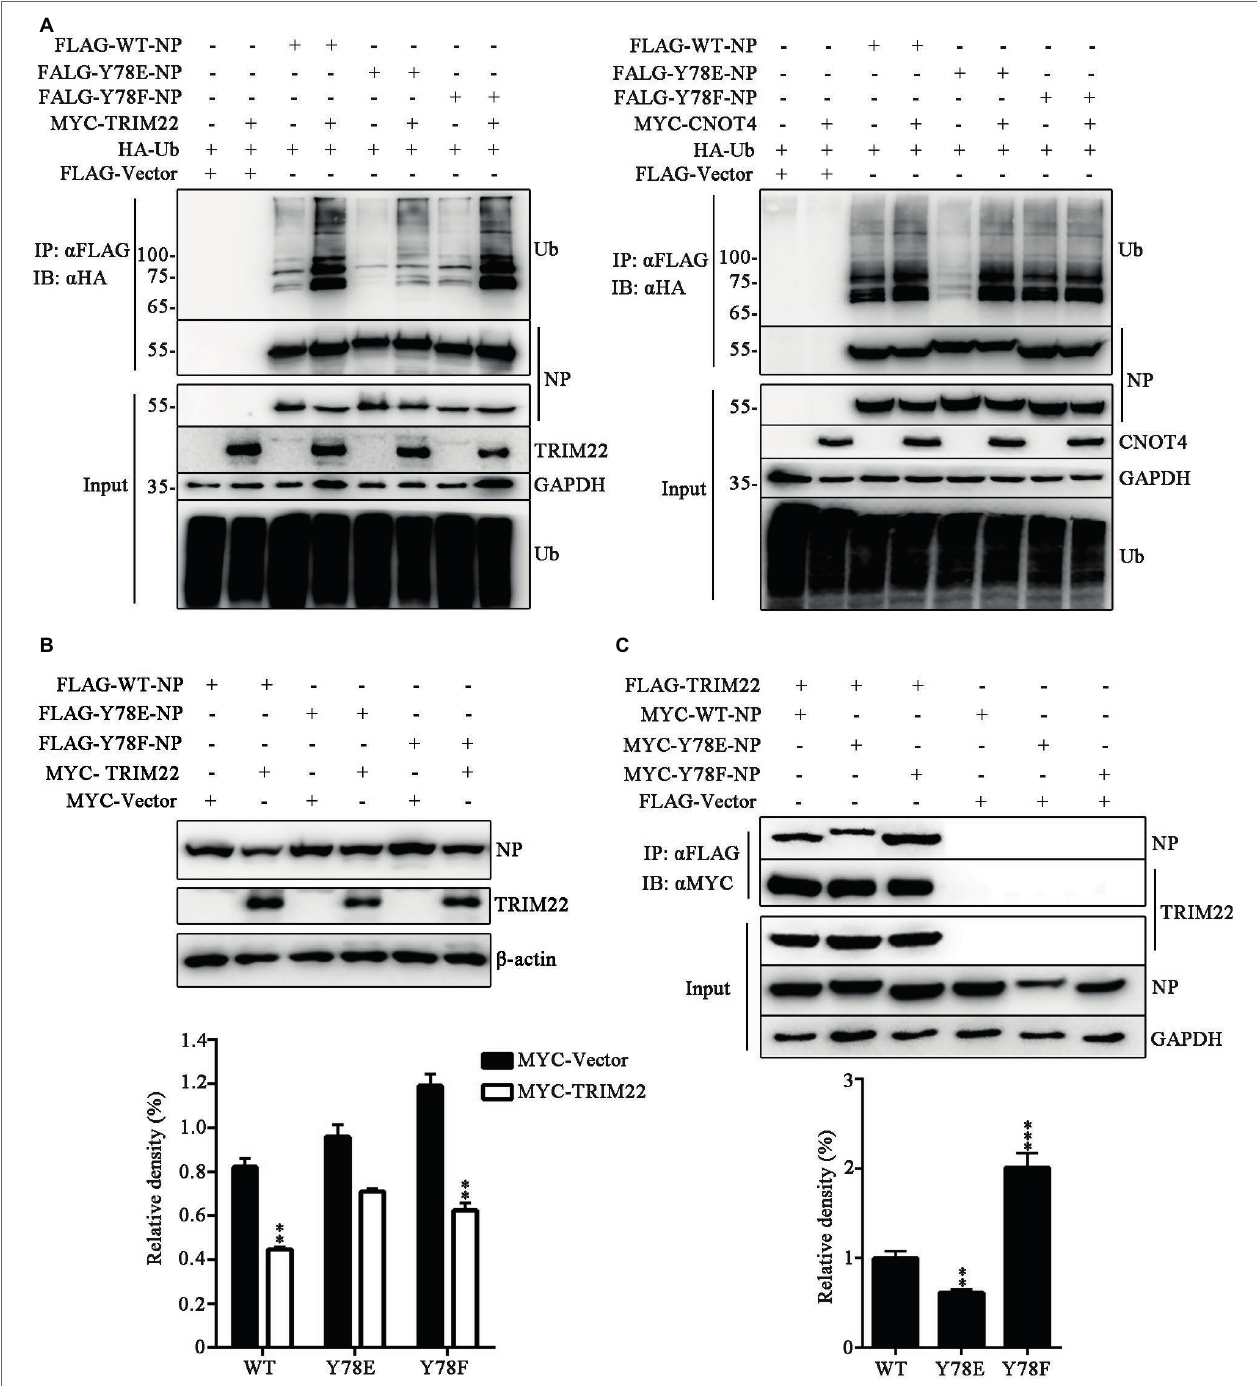
FIGURE 8 | Y78 phosphorylation regulates TRIM22-mediated NP ubiquitination. (A) Effect of TRIM22 and CNOT4 on the ubiquitination of NPs. Immunoblot analysis of lysates in 293 T cells transfected with various combinations of plasmids for 30 h, followed by immunoprecipitation with anti-FLAG beads. (B) Effect of TRIM22 on the stability of IAV NPs. 293 T cells were transfected with FLAG-NP (WT, Y78F, or Y78E) plasmid, along with MYC-TRIM22 or an empty vector for 30 h. Cells were lysed and then detected with corresponding antibodies (top). The relative density of NPs was normalized to β -actin (below). Data are shown as mean + SD ( n = 3). Differences of NP stability between the TRIM22- and Vector-transfected groups were tested using unpaired Student’s t -test. ** p < 0.01. (C) Effect of Y78 phosphorylation on the interaction of TRIM22 with WT or mutant NPs. 293 T cells were transfected with MYC-NP (WT, Y78F, and Y78E) and FLAG-TRIM22 and lysed at 30 h.p.t. FLAG-TRIM22 was immunoprecipitated with anti-FLAG beads, and the associated NPs were detected using rabbit anti-NP antibody (top). The relative density of immunoprecipitated NPs was normalized to immunoprecipitated TRIM22 (below). Data are shown as mean + SD ( n = 3). Differences between mutant and WT NPs were evaluated using one-way ANOVA followed by Dunnett’s test. ** p < 0.01; *** p <